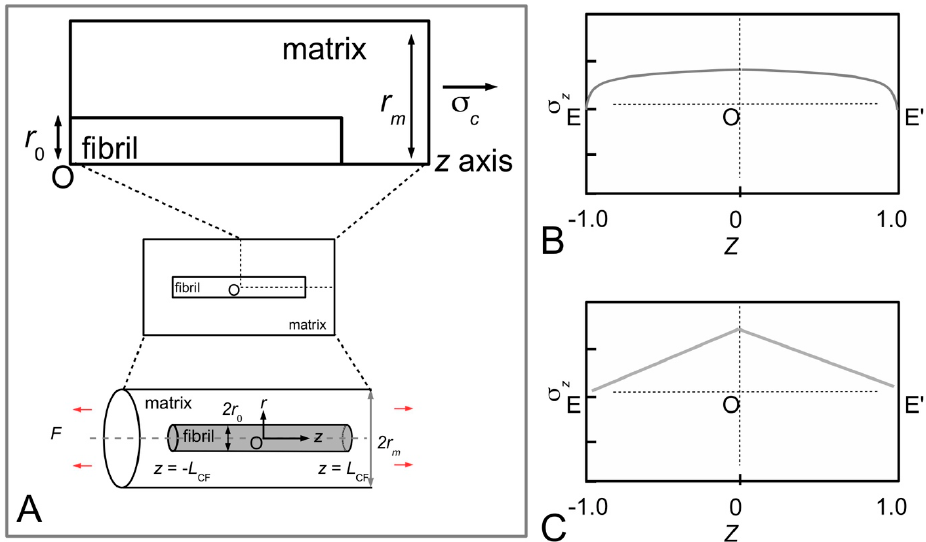
Figure 7. Collagen fibril axial stress, σ z , distributions. ( A ) Model of connective tissue featuring a collagen fibril embedded in ECM. The proposed interfacial shear stress distributions in the ( B ) Shear-lag and ( C ) Shear-sliding models for collagen fibril biomechanics [99,101]. In part B and C, symbols F represents the force acting on the ECM (red arrow represents the direction of F); σ c represents the stress acting on the tissue in the direction of the fibril, r m represents the radius of the matrix surrounding the fibril; r 0 represents the radius of the fibril; L CF represents the half-length of the fibril; r and z are coordinates of the cylindrical polar coordinate system; Z represents the normalized coordinate of z (i.e., Z = z / L CF) which is intended to describe the fractional distance along the fibril axis from the fibre centre, Z = 0 (i.e., O), to the respective fibre ends, Z = 1 or − 1; E and E’ represent the ends of a fibril (Figure 6).